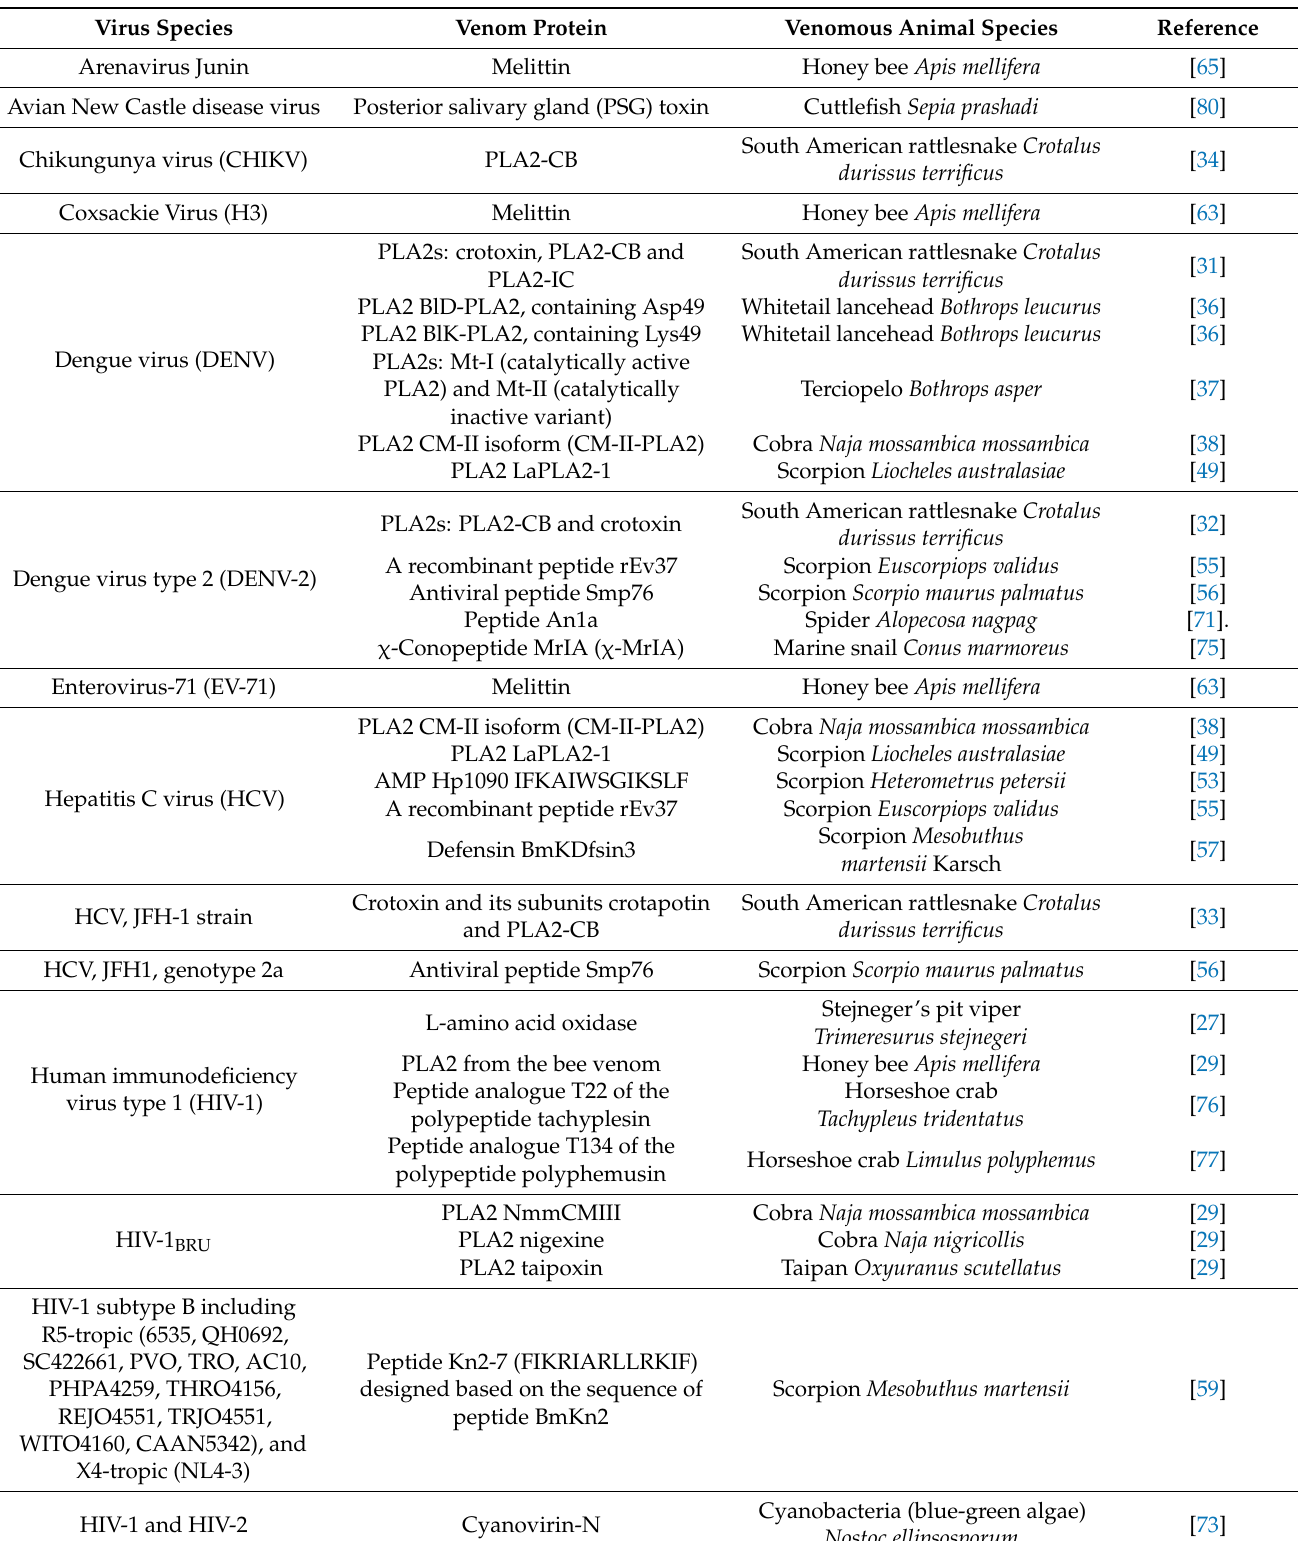
Table 1. The animal venom peptides and proteins with antiviral